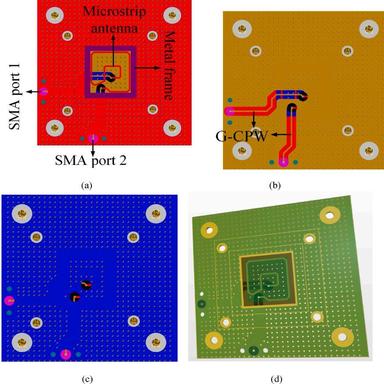
Microstrip antenna fixture PCB board designed in Altium Designer: 2D structure:(a)Top-layer; (b) Mid-layer; (c) Bottom-layer; (d) 3D structure.